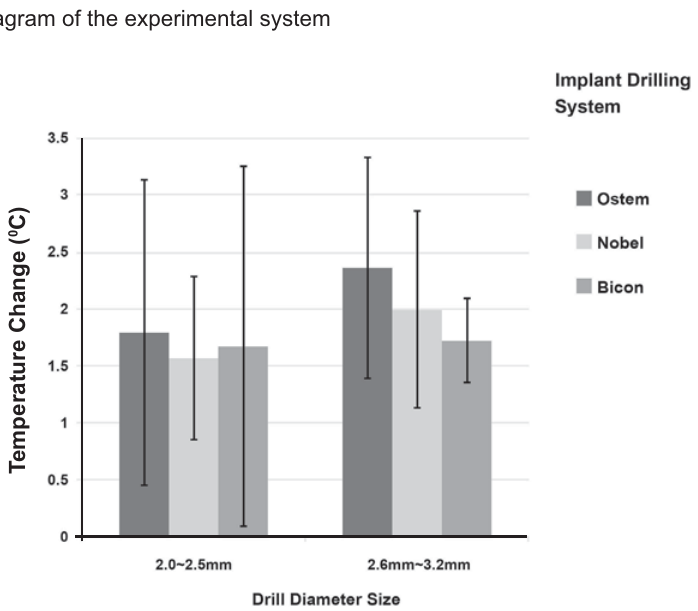
Figure 4- Relationship between drill diameter and bone